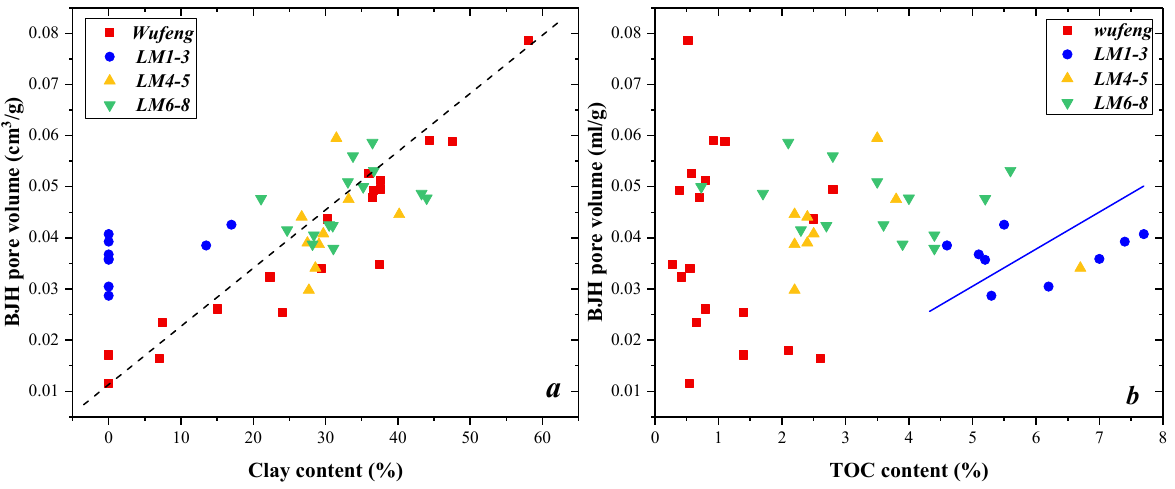
Figure 13. The correlation between BJH pore volume and clay content ( a ), TOC content ( b ) in the W202 well.